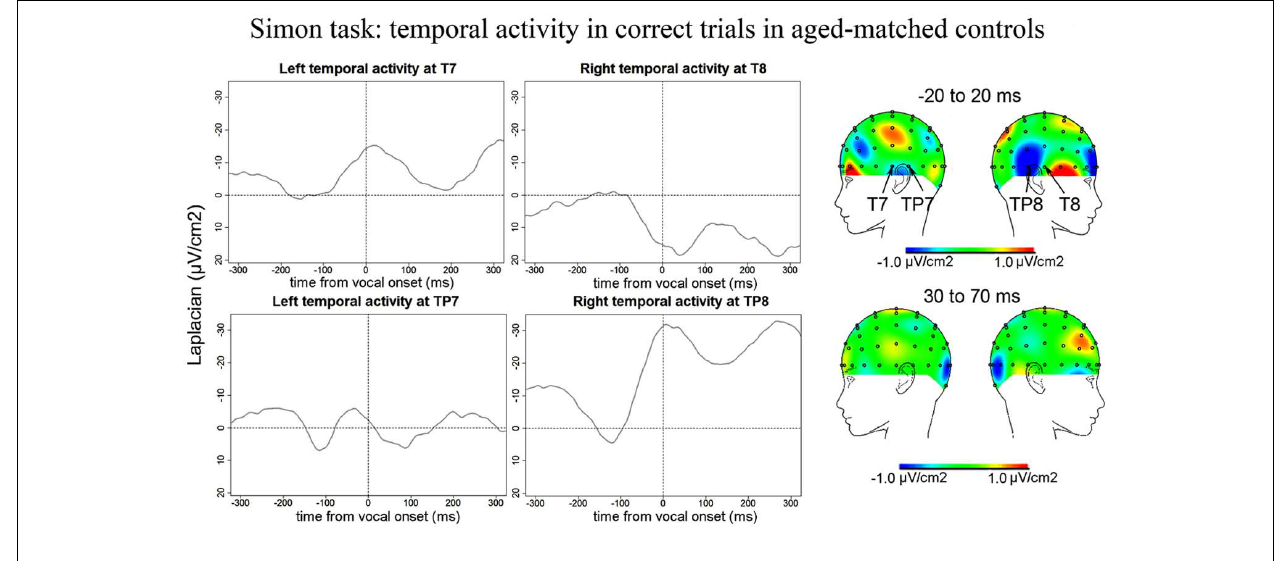
FIGURE 9 | EEG activity for control group after surface Laplacian transformation, recorded at left (T7,TP7) and right (T8,TP8) temporal electrodes for correct trials in the Simon task. Zero time represents vocal